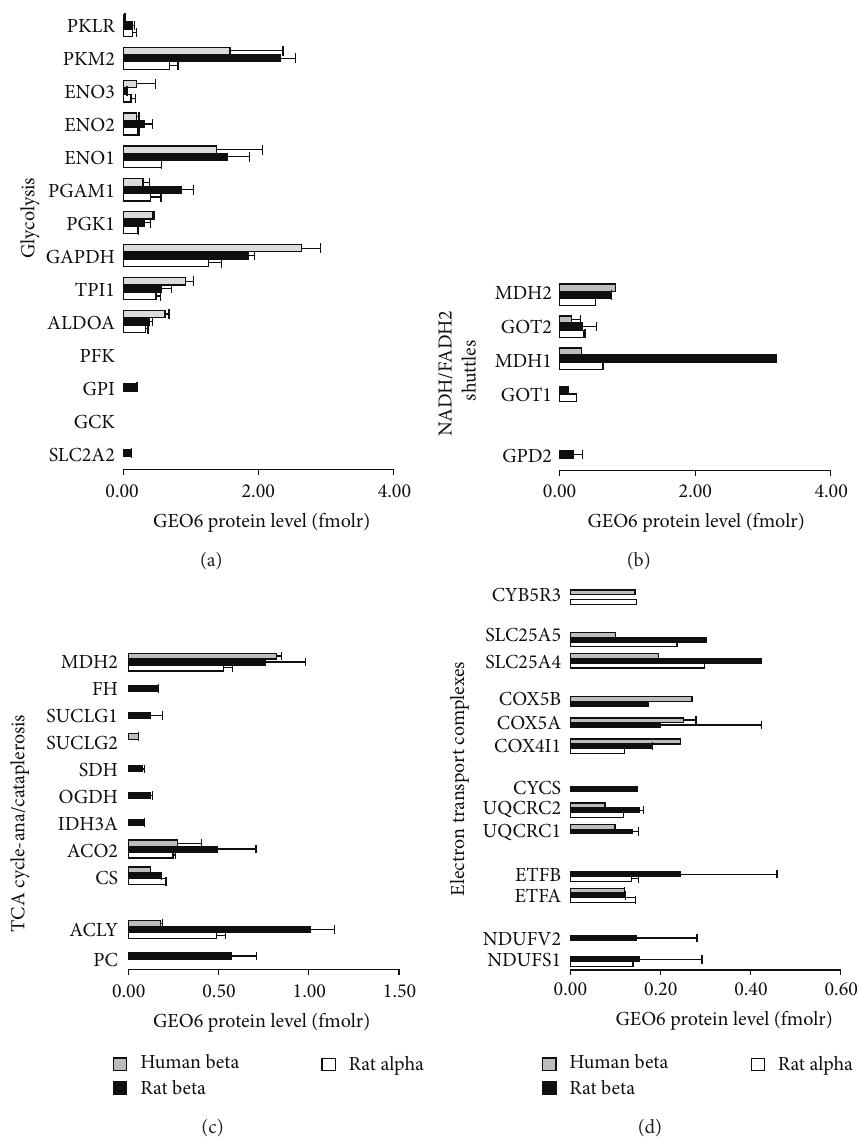
Figure 2: Proteome architecture of intermediary metabolic pathways in rat and human islet endocrine cells. Data represent mean ± SD geometrically normalized protein amounts in rat beta (black bars, 𝑛 = 3 ), rat alpha (white bars, 𝑛 = 3 ), and human beta cells (gray bars, 𝑛 = 4 ). No error bar means confident detection in just 1 biological replicate. Proteins are denoted by their official gene symbol as recorded by UniProt (May 2014) and grouped for their main metabolic pathway: (a) glycolysis, (b) NADH/FADH2 shuttles. (c) Krebs cycle and ana- or cataplerosis. (d) Mitochondrial Electron Transport Complexes I–V. Full width at half maximum can be used as statistical discrimination limit for differential protein expression, corresponding to 2.35 times the median total error (19%) =